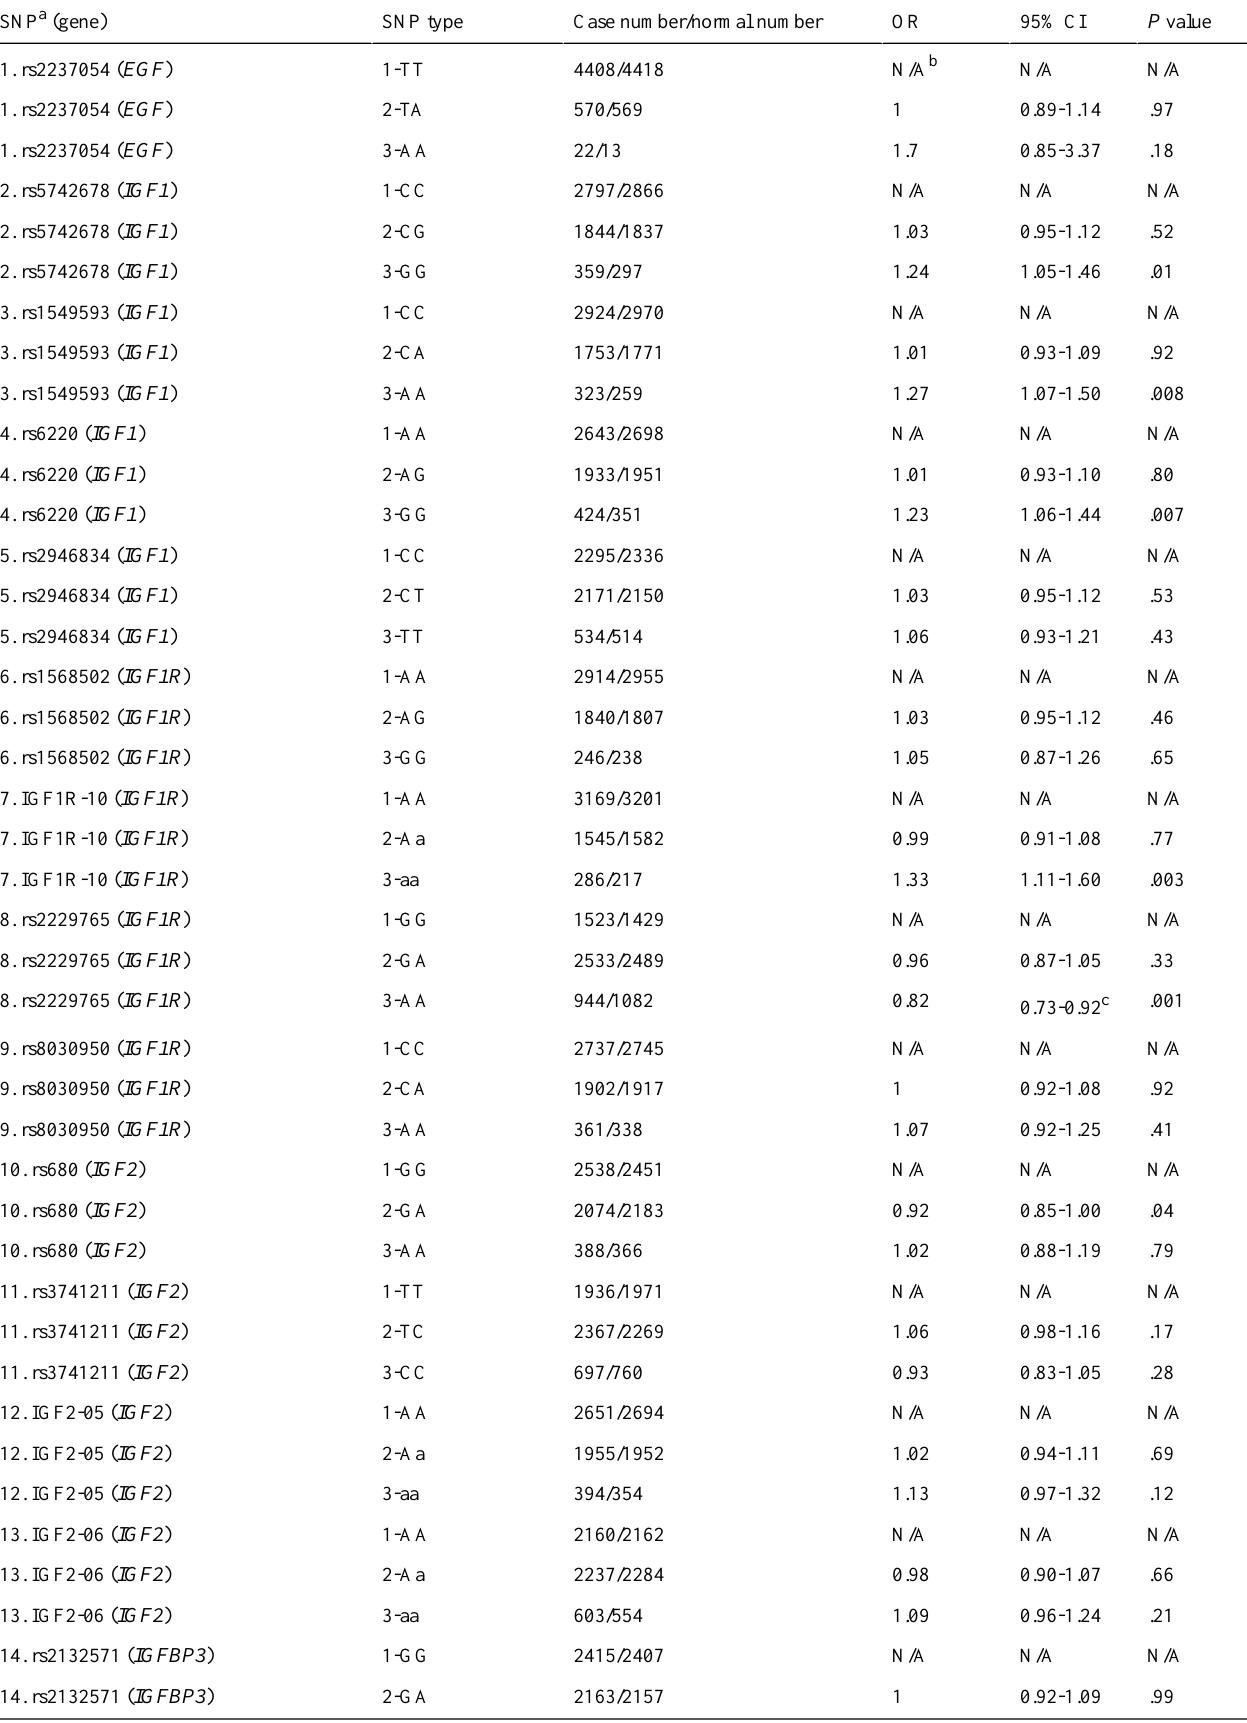
Table 2. Estimated effect from individual single-nucleotide polymorphisms of 26 growth factor–related genes for the occurrence of breast